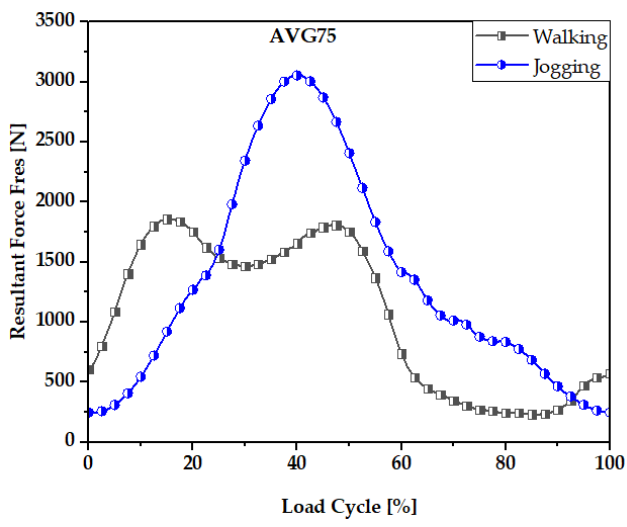
Figure 3. Resultant Force, F res , values for walking and jogging loading conditions.